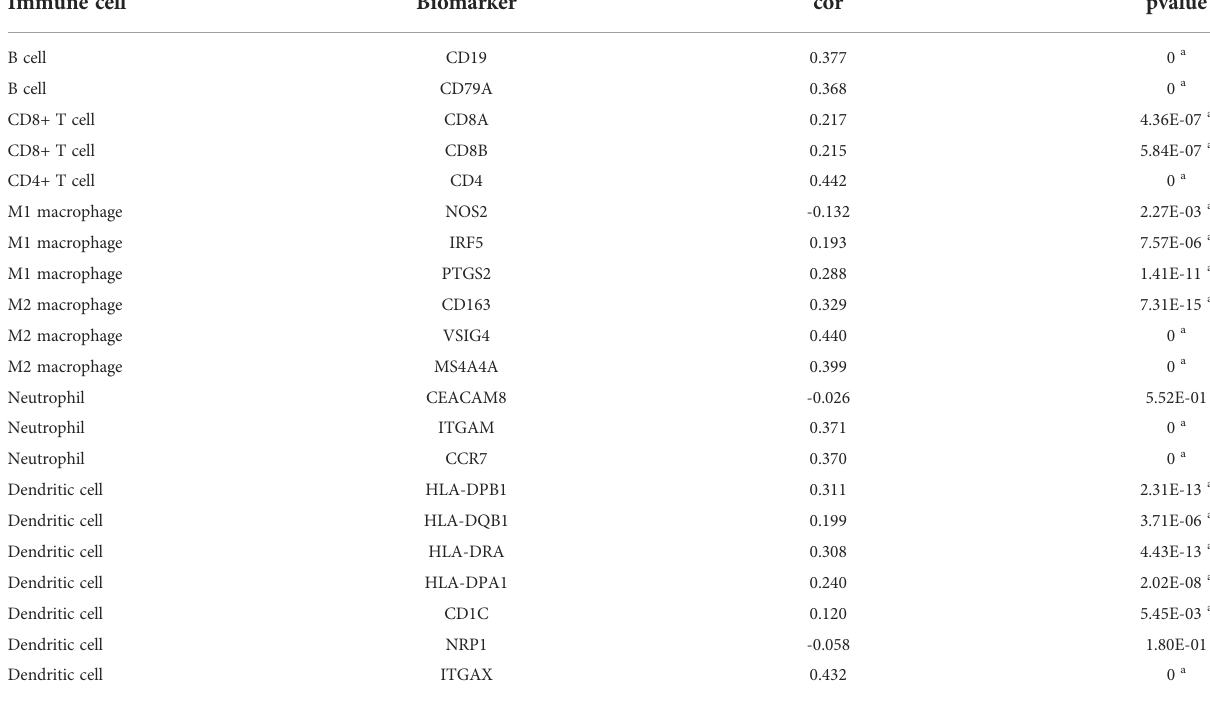
TABLE 2 Correlation analysis between PLAUR and biomarkers of immune cells in KIRC.